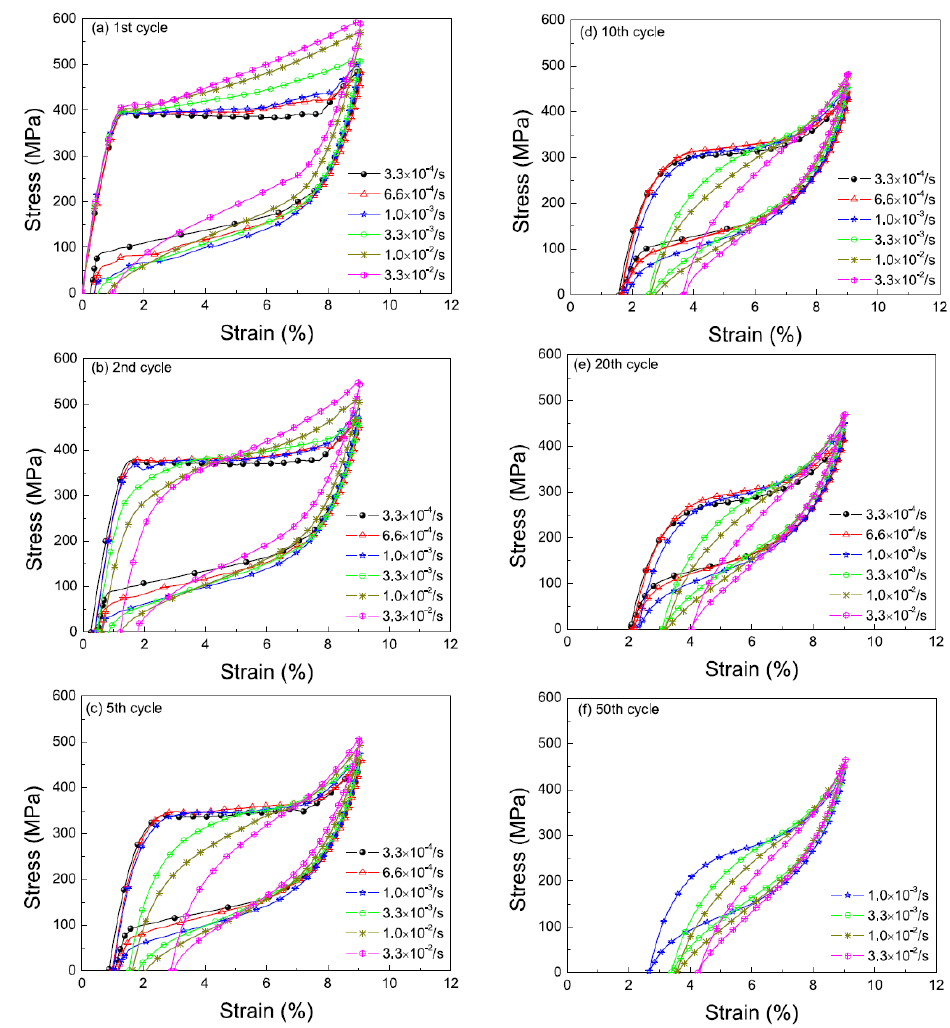
Figure 8. Rate-dependent stress – strain curves in different cycles: ( a ) 1st cycle; ( b ) 2nd cycle; ( c ) 5th cycle; ( d ) 10th cycle; ( e ) 20th cycle; ( f ) 50th cycle [37]. (Reprinted from Ref. [37], Figure 3, 2016, with permission from Elsevier.)